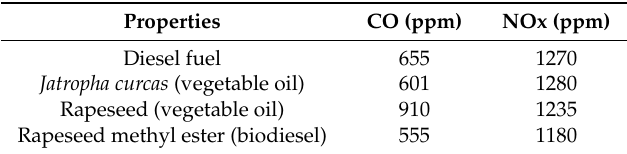
Table 4. The exhaust gases emissions recorded in a modified 1D80 Hatz direct-injection engine with full load and torque of 36 Nm at 1800 rpm